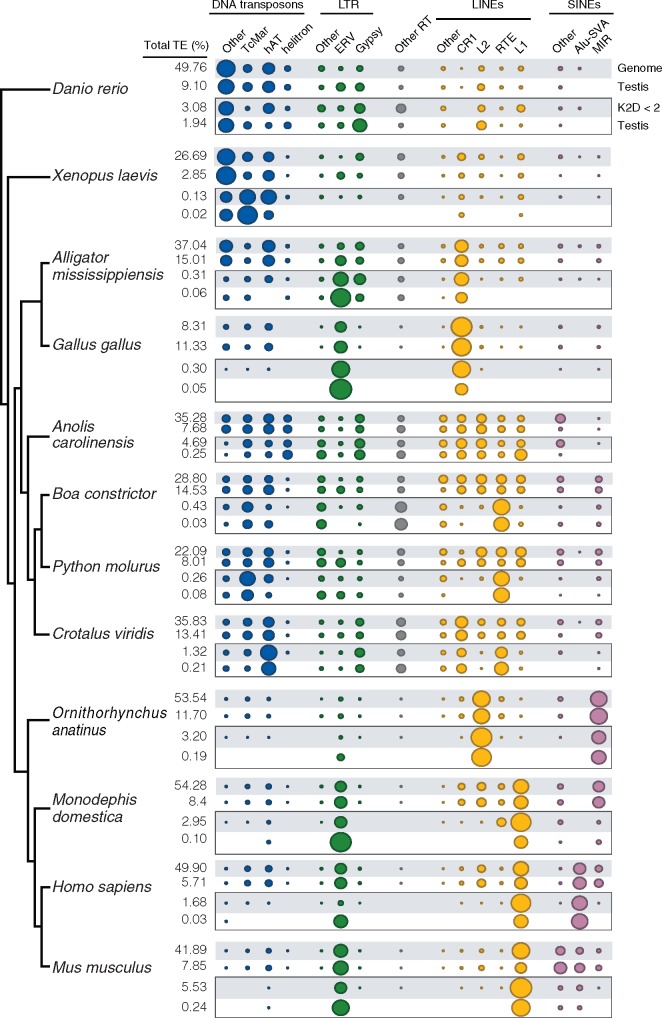
—Relationship between genomic and transcriptomic TE relative composition in the male germline. Area of the circles in the balloon plot reflects the percentage of major TE subfamilies (blue, DNA transposons; green, LTRs; gray, PLE and DIRS; yellow, LINEs; violet, SINEs) relative to the total genomic TE content (top row, gray background) and to the total-TE transcriptome (white background). In the box, the same relationship is displayed for recently inserted TE copies (with a Kimura distance < 2%) and recent TEs in the transcriptome. Values to the left report the real proportion of TEs (TE content %) in the genomes and transcriptomes. We find support for high TE transcription in testis transcriptomes (up to 15%), which perfectly match the relative composition of the genome. In contrast, for recent TEs, some families are entirely missing in the transcriptome despite their presence in the genomic background. Balloon plot additionally highlights variability in TE landscapes across vertebrates.